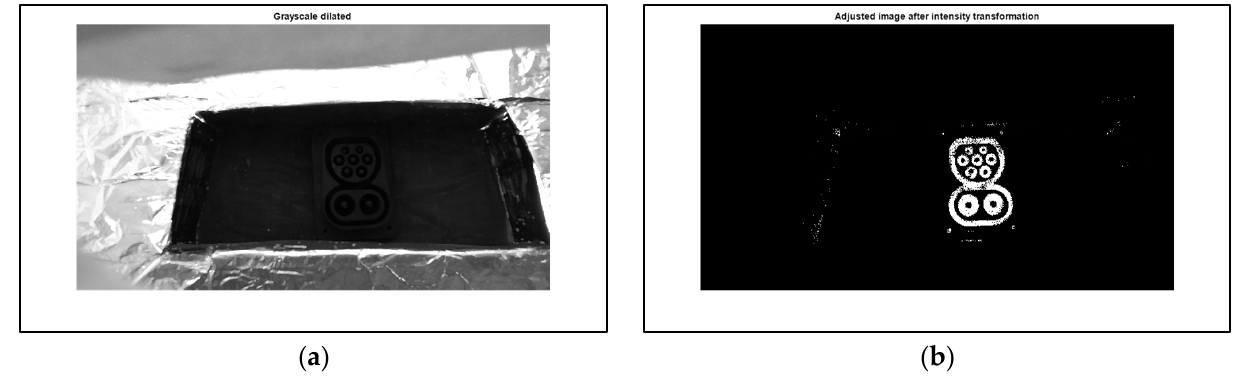
Figure 5. ( a ) Grayscale dilation result and ( b ) intensity transformation result.